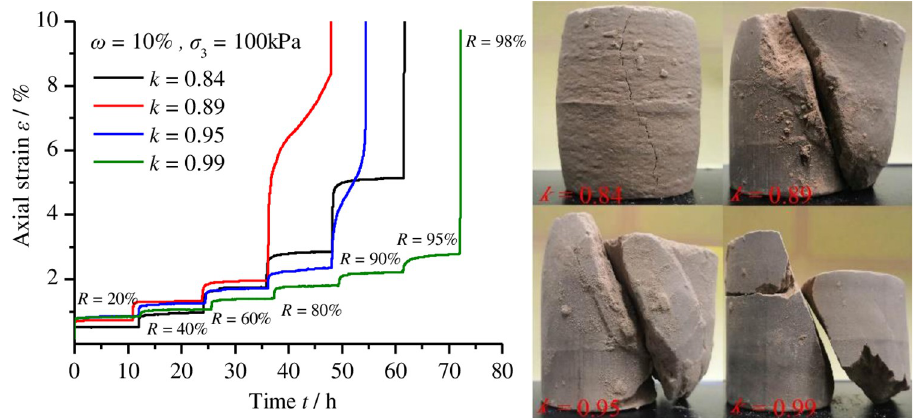
Fig 5. Creep curves and specimens. (a) Relationship curves of axial strain over time for remoulded loess under various levels of compactness; (b) specimens after the creep test.